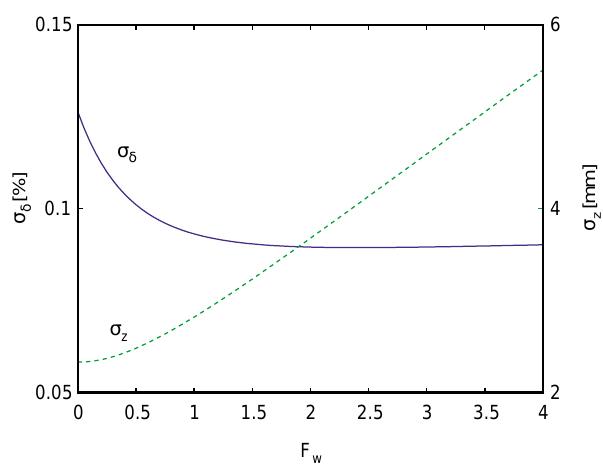
FIG. 13. (Color) MDR extracted energy spread s d and bunch length s z plotted against F w .